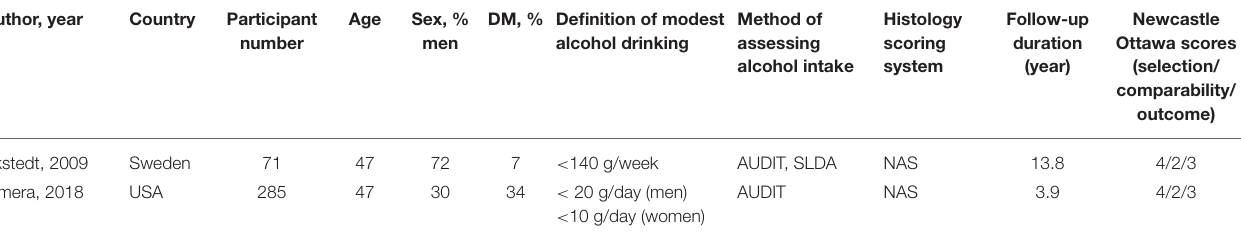
TABLE 1B | Characteristics of longitudinal follow-up studies on histological progression between non-drinkers and modest drinkers included in the review. Author,